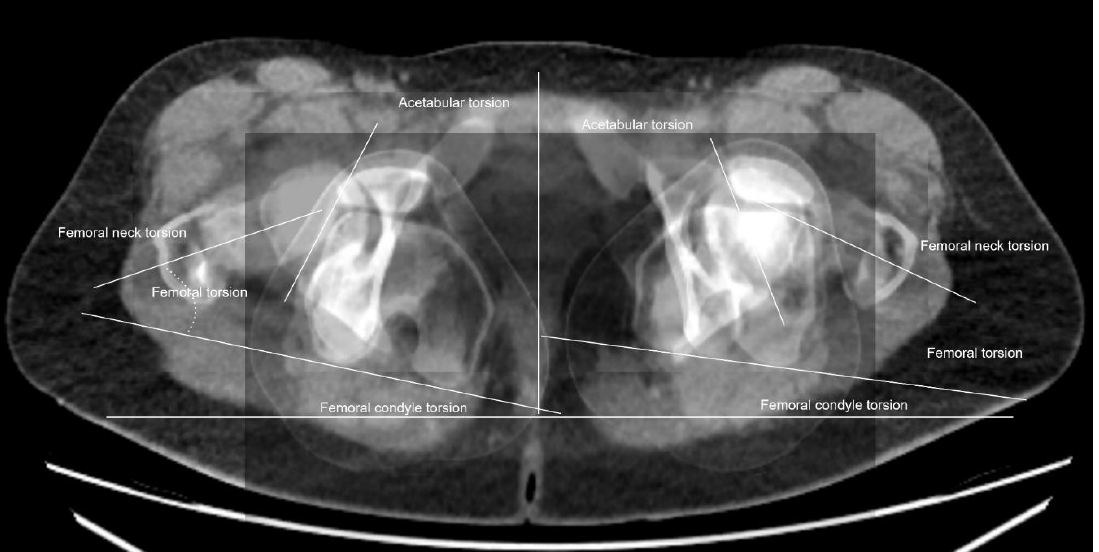
Figure 1. Rotational alignment in a 29-year-old patient with left-sided dysplastic hip: Femoral neck rotation +22°, femoral condyle rotation − 24°, femoral rotation +46°, tibial plateau rotation − 21°, and femorotibial rotation difference +3°.